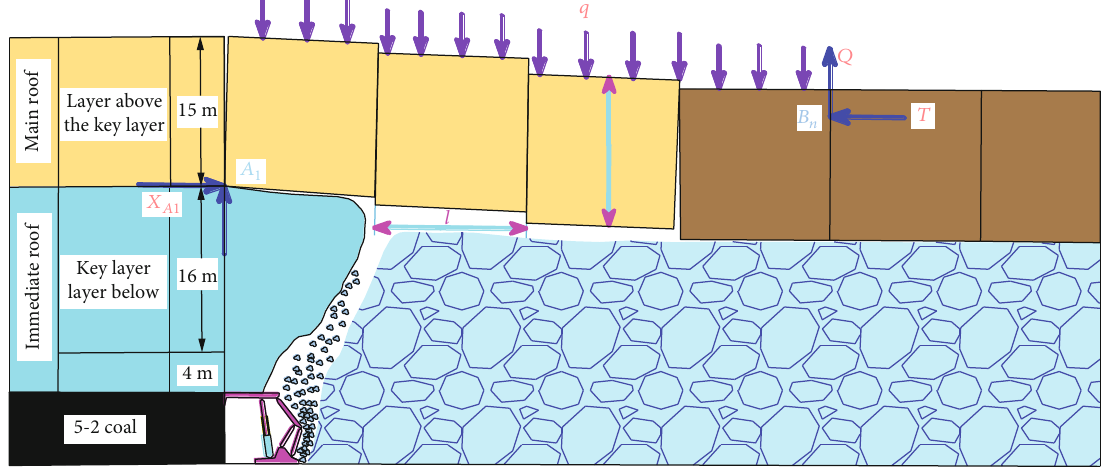
Figure 8: The force analysis of study object.